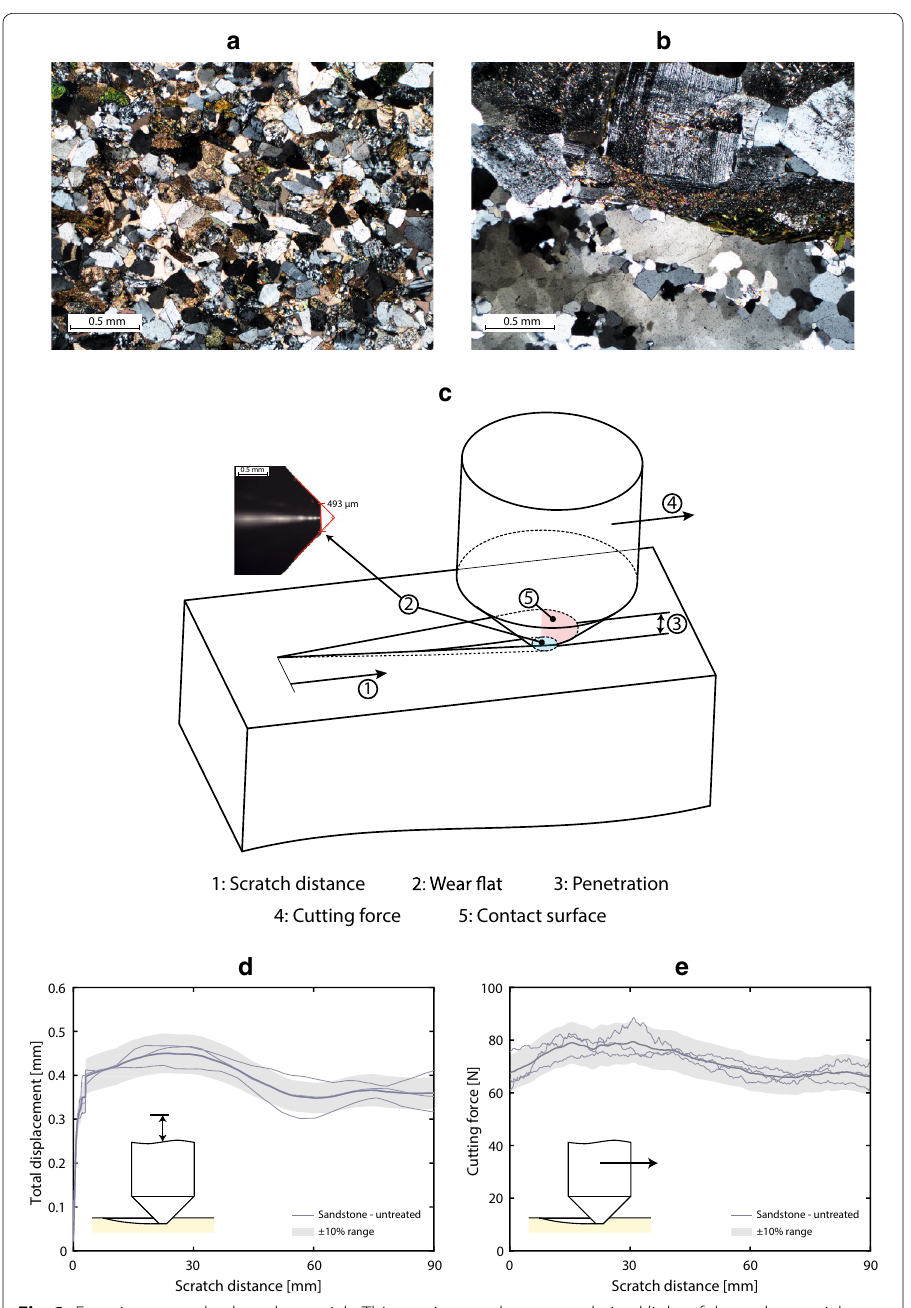
Fig. 2 Experiment methods and materials. Thin sections under cross-polarized light of the rock materials used in this work, i.e., Rorschach sandstone ( a ) and Grimsel granite ( b ). The experiment testing concept and the parameters measured to investigate rock–bit interaction are shown in c . During the experiments, the tool scratches the rock surface along a prescribed scratch distance ( c .1), flattening the tool tip ( c .2), which is optically imaged and investigated after the test. The tool penetration ( c .3) and cutting forces ( c .4) are monitored during the experiment. After the test, knowledge of wear flat and tool penetration enables determining the tool’s contact surface ( c .5). During the test, the total, vertical tool displacement is monitored ( d ) and afterwards processed, together with the wear flat at the tool tip to assess the actual penetration of the tool. During the test, the cutting forces exerted on the tool are measured as well ( e ). d , e The total displacement and cutting force signals obtained during several tests (thin lines), while the moving-averaged signal (thick line) is shown for comparison for the untreated sandstone material, together with the